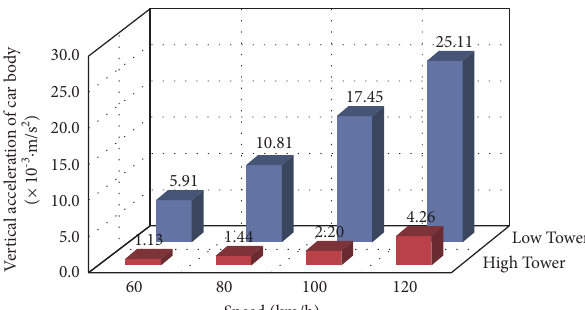
Figure 11: Comparison of vertical acceleration of car body.